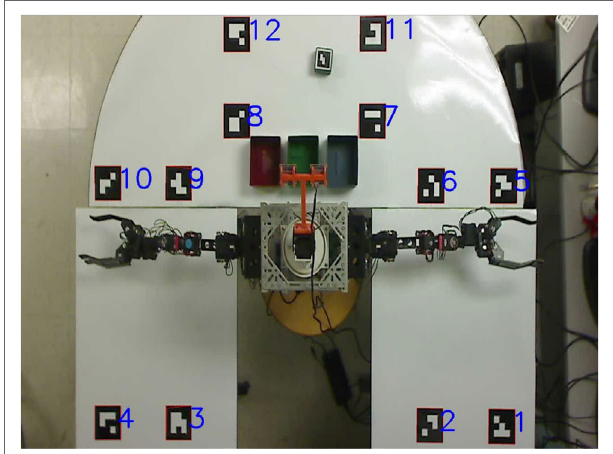
FigUre 2 | Workspace markers arranged in a predefined pattern (as captured from the overhead camera)